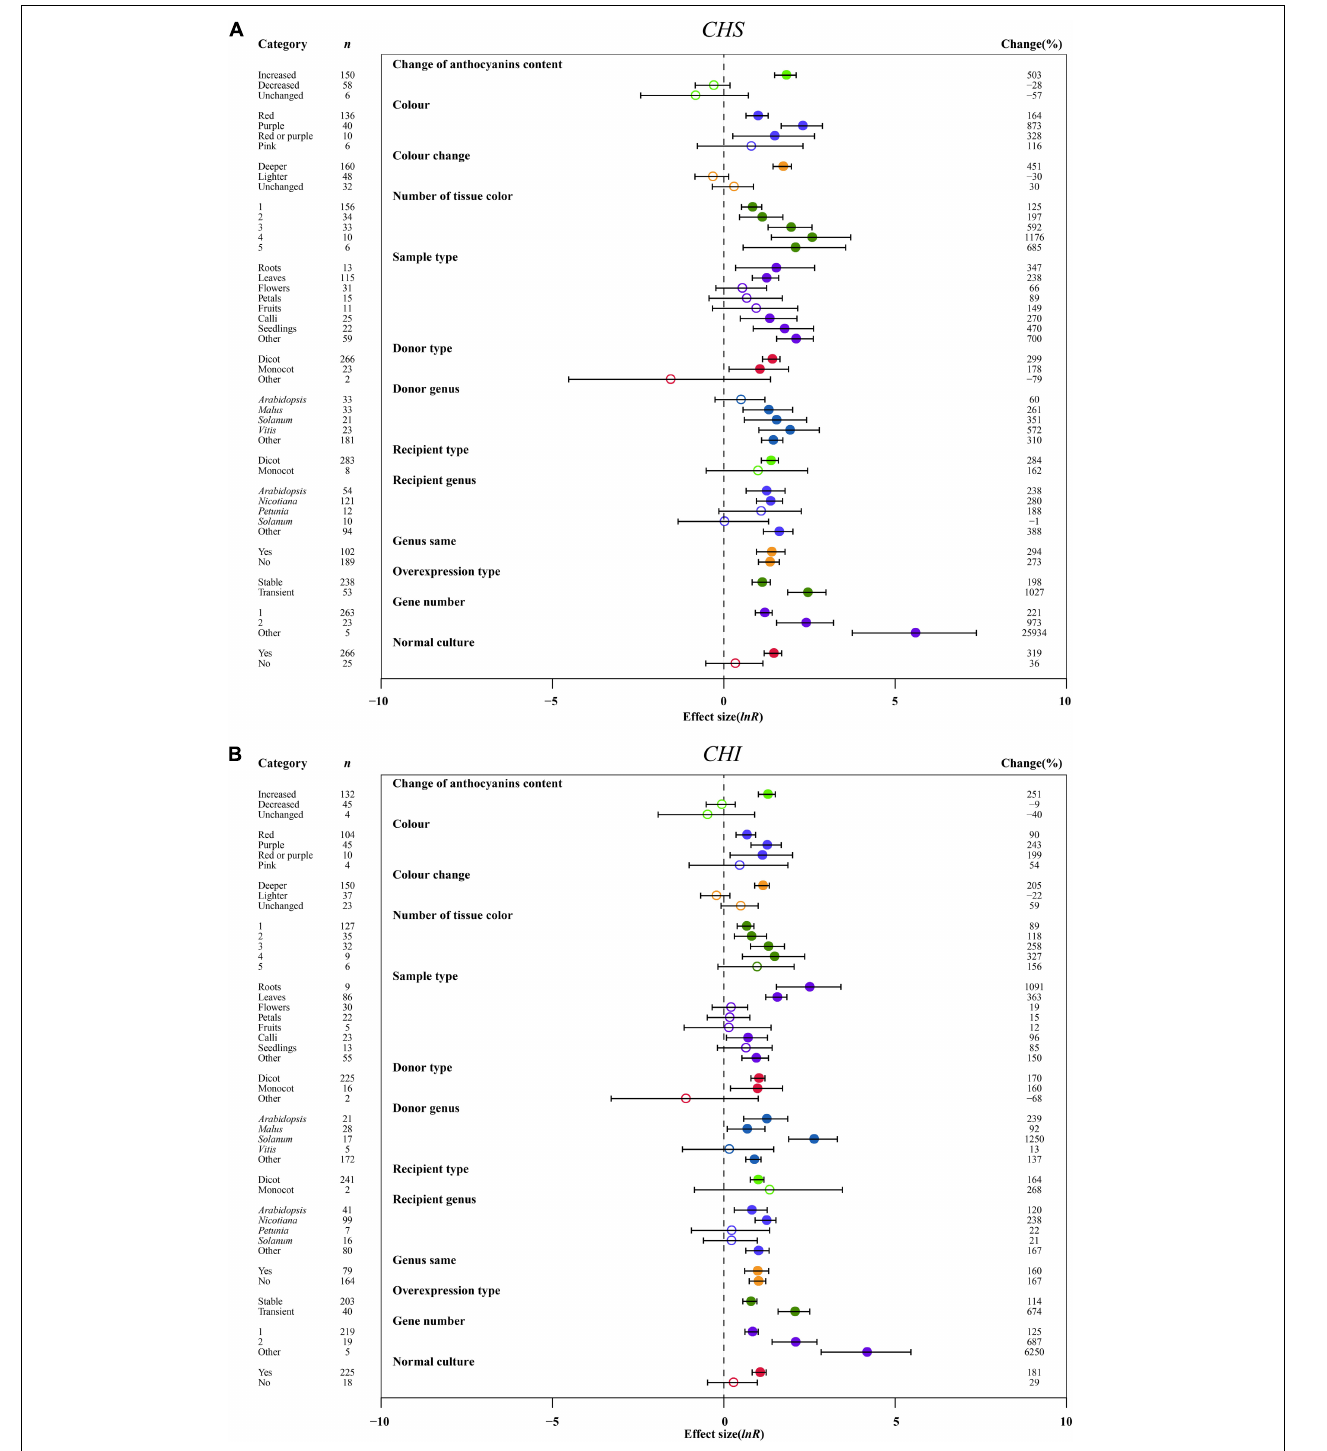
FIGURE 6 | Summary effects (ln R ) of the influence of MYB overexpression on the expression of CHS (A) and CHI (B) in plants. Ratios are unit-less. The ratios illustrate the strength of MYB overexpression on the summary effects of the expression of CHS and 4HI compared with the controls. Circles and horizontal bars indicate the summary effects and the 95% CI of thirteen moderator variables, respectively. n represents the number of studies. Subgroup list levels (subgroups or categories) of each moderator. The percent change (to the right of plots) refers to the raw percentage increase or decrease in the expression of C4H and 4CL induced by overexpression of MYB . The moderator variables of the examined plants are colored and distinguished by different colors. Closed and open circles indicate the effects of significance and insignificance, respectively.